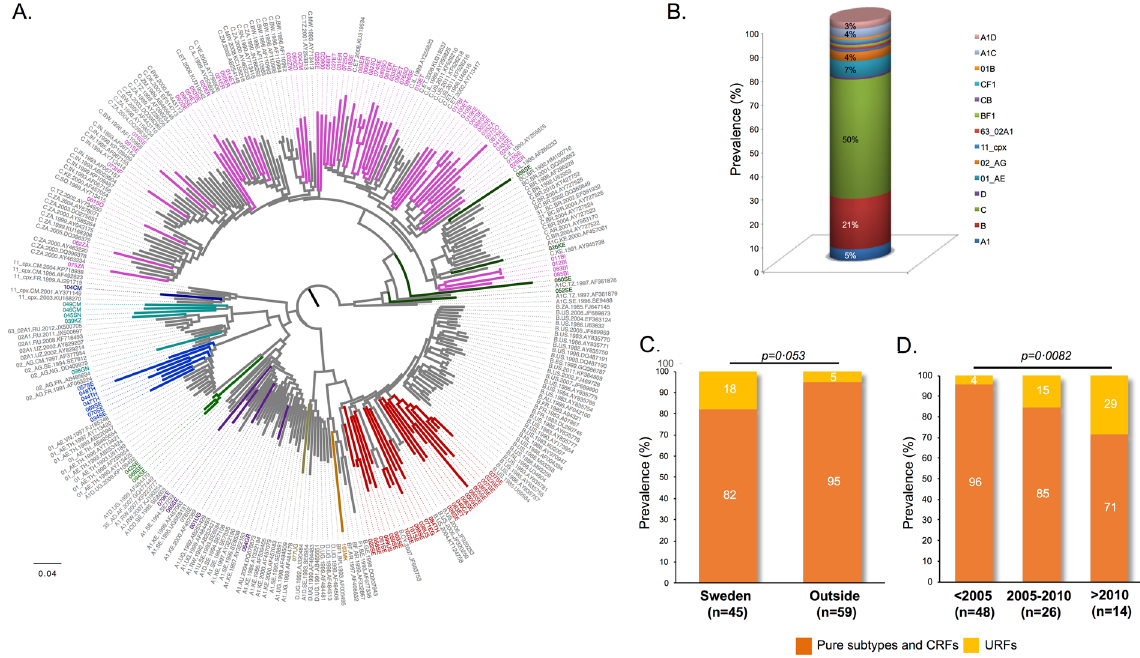
Figure 1. ( A ) Maximum-likelihood phylogenetic analysis. The HIV-NFLG sequenced in our study (n = 104) and a unique set of 175 reference sequences downloaded from Los Alamos database were used. ( B ) Distribution of HIV-1 pure subtypes (n = 80), circulating recombinant forms (CRFs) (n = 13) and unique recombinant forms (URFs) (n = 11) based on three subtyping tools (REGA v3, RIP 3.0 and COMET-HIV) and ML-phylogenetic analysis. ( C ) Proportion of pure subtypes/CRFs and URFs among patients infected in or outside Sweden, according the reports from the treating physician. A higher proportion of URFs was identified among patients infected in Sweden (n = 8; 18%) than outside (n = 3; 5%) (Fisher’s exact test p = 0·0523). ( D ) Distribution of pure subtypes/CRFs and URFs in relation to year of transmission predicted by the CD4 + T-cell decline trajectory algorithm (n = 79) or by a serologically verified primary HIV infection (n = 9). The trends indicate a significant increase of URFs in newly diagnosed patients in Sweden over time (Chi-square test: 6·986; p =